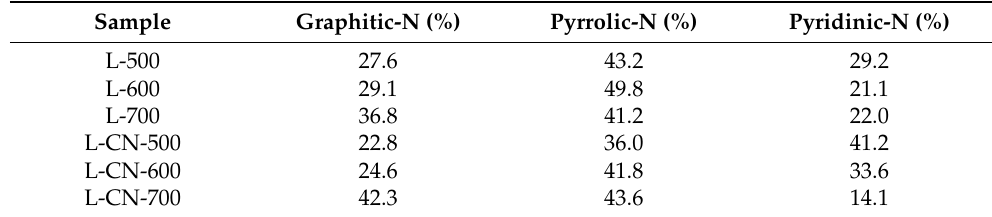
Figure 6. N 1s XPS spectra of L-500 ( a ), L-600 ( b ), L-700 ( c ), L-CN-500 ( d ), L-CN-600 ( e ), and L-CN-700 ( f ) samples. Table 3. Relative peak areas determined from the N 1s XPS spectra of lignite-based porous carbons.